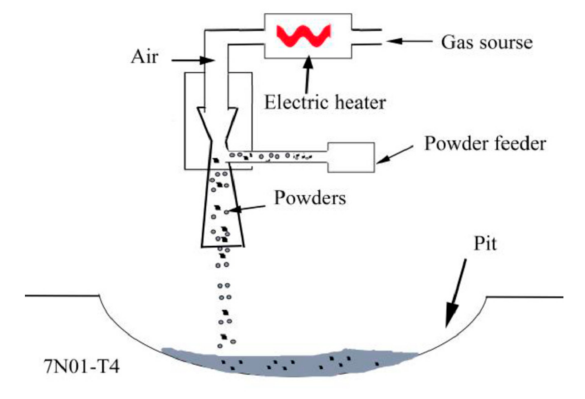
Figure 3. A schematic illustration of the repair